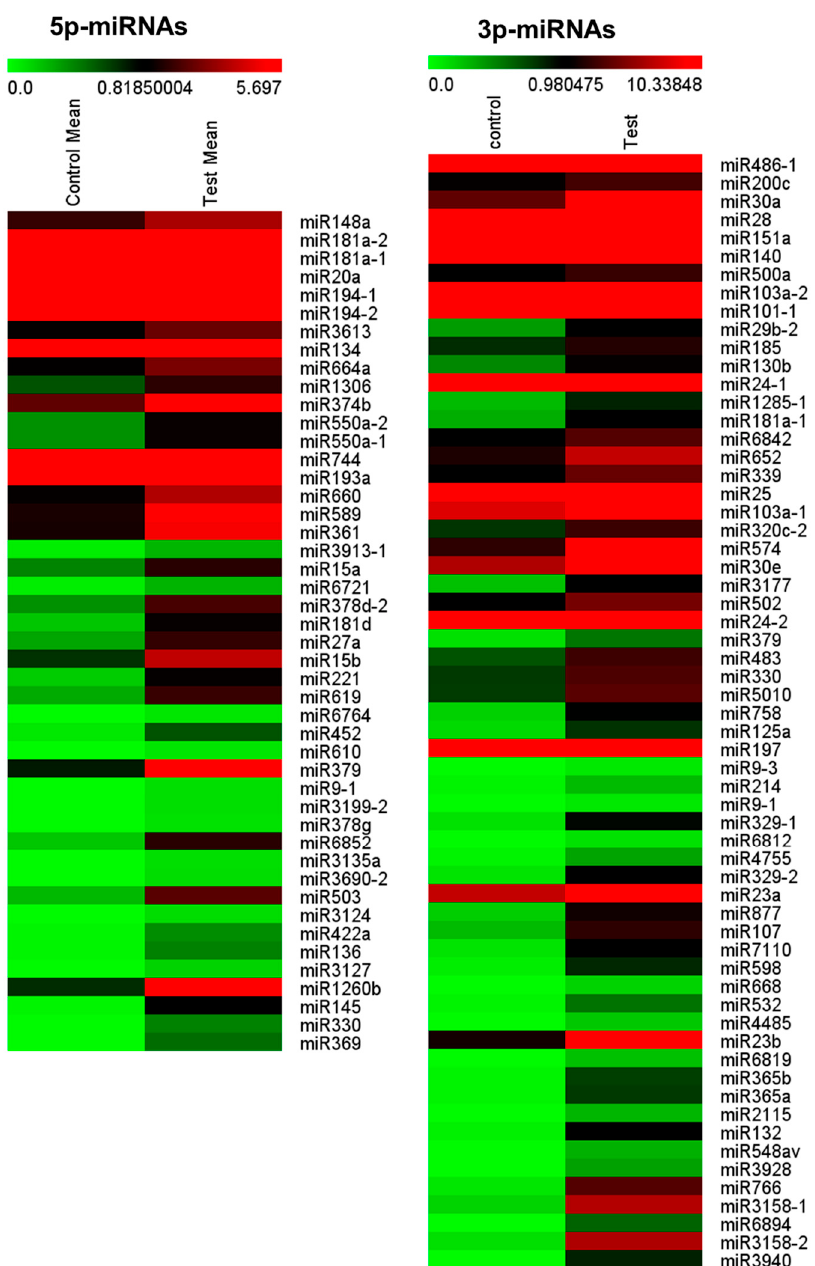
Figure 4. Cluster analysis of 107 differentially expressed miRNAs in patients with focal cortical dysplasia (Test Mean) and controls (Control Mean) by heatmap MeV4.9 software. Green = lower than mean intensity; red = higher than mean intensity. The conventional value of p < 0.05 was used for each miRNA.